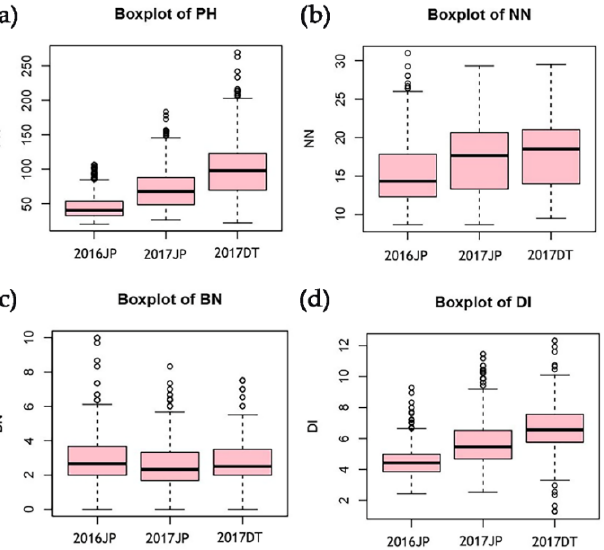
Figure 1. Boxplots of four plant architecture-related traits in soybean mini core collection in three environments. ( a – d ) Boxplots of PH, NN, BN, and DI.